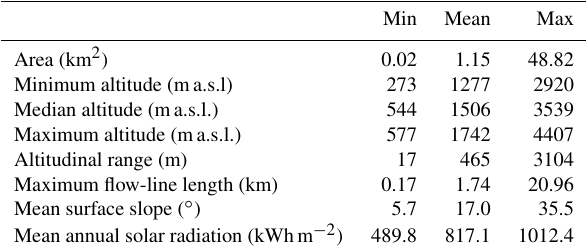
Table 2. Statistics for glaciers on the Kamchatka Peninsula in 2000 (topographic attributes are derived from the SRTM 30m